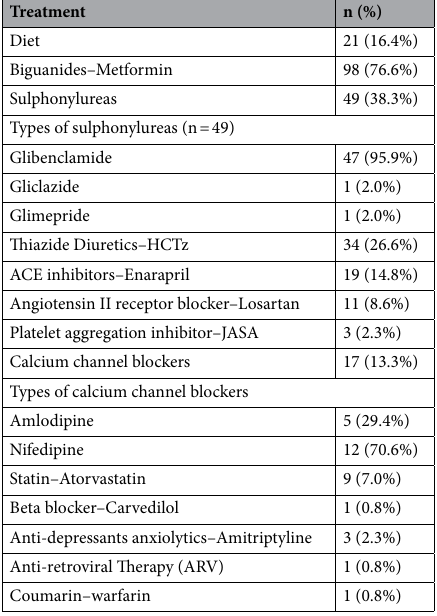
Table 3. Treatment characteristics.